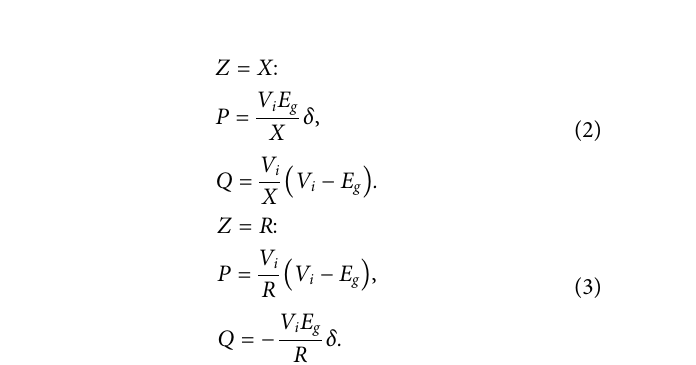
FIGURE 1 | Equivalent model of parallel